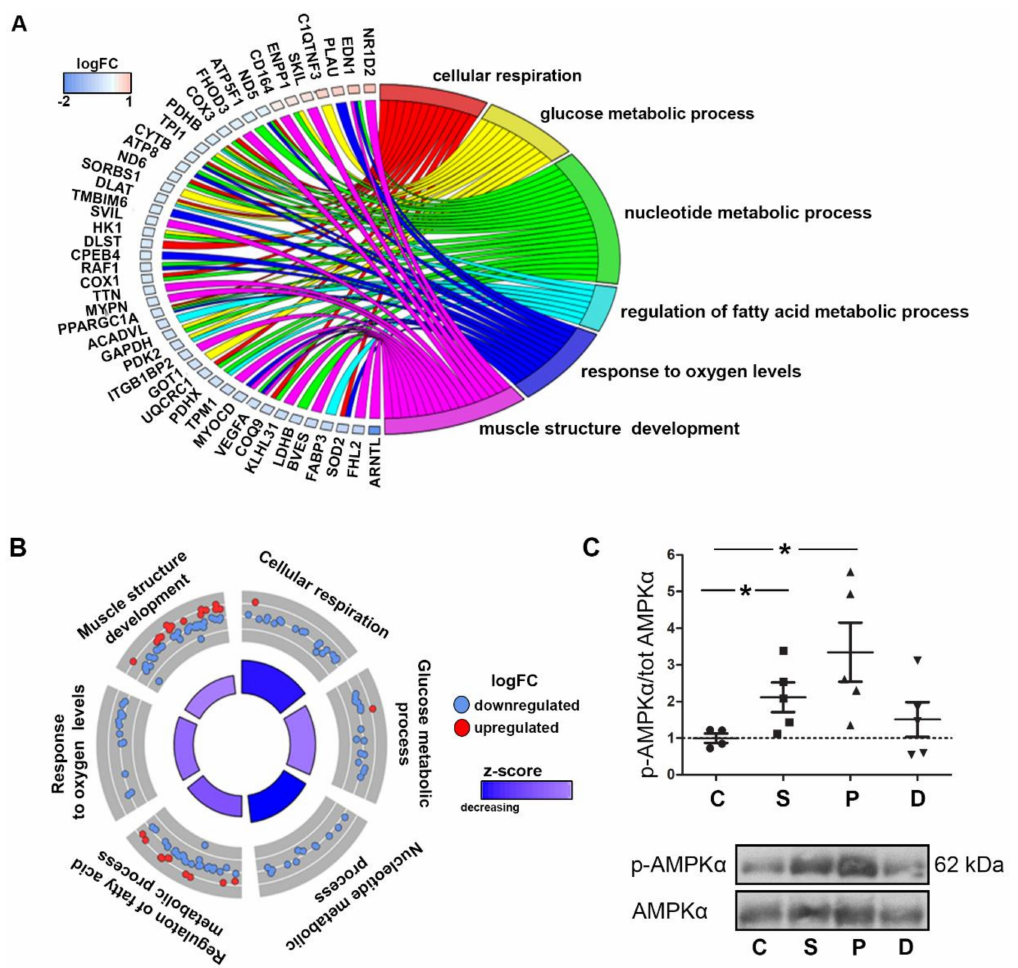
Figure 3. Decreased metabolism and muscle structure are enriched by serotonin, pergolide, and dexfenfluramine treatment. AMPK activation by serotonin and pergolide. ( A ): Chord plot shows